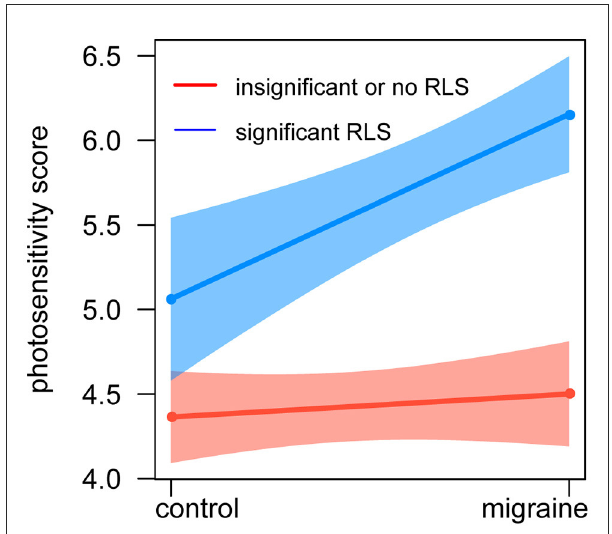
FIGURE3 Relationship between photosensitivity, RLS, and migraine. The red line represents insignificant or no shunt, the blue line represents significant shunt, and the whiskers show a 95% CI. The X-axis represents the groups of healthy control and migraine, and the Y-axis represents the photosensitivity score. There was an interaction between shunt and migraine for the association with greater photosensitivity. CI, confidence